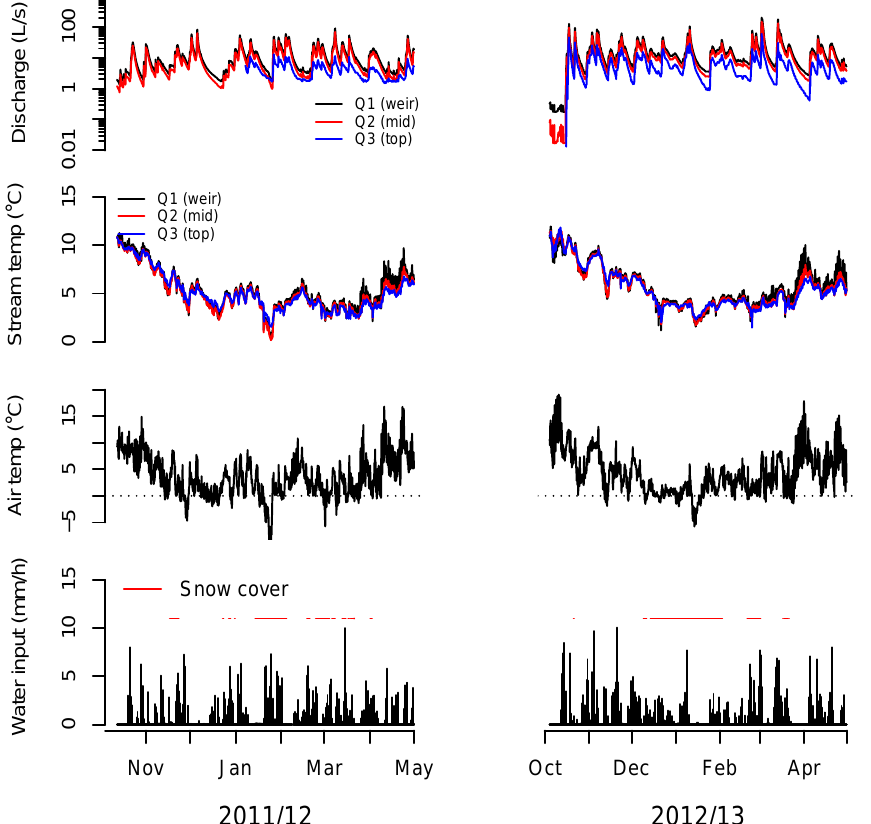
Fig. 3. Hydroclimatic overview for the 2011/2012 and 2012/2013 winter periods (October to May). Water input refers to rainfall and snowmelt measured by the snow lysimeter located at the open